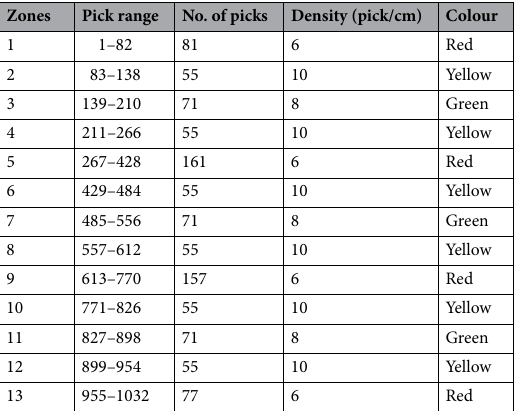
Table 2. Weave design parameters of honeycomb structure.